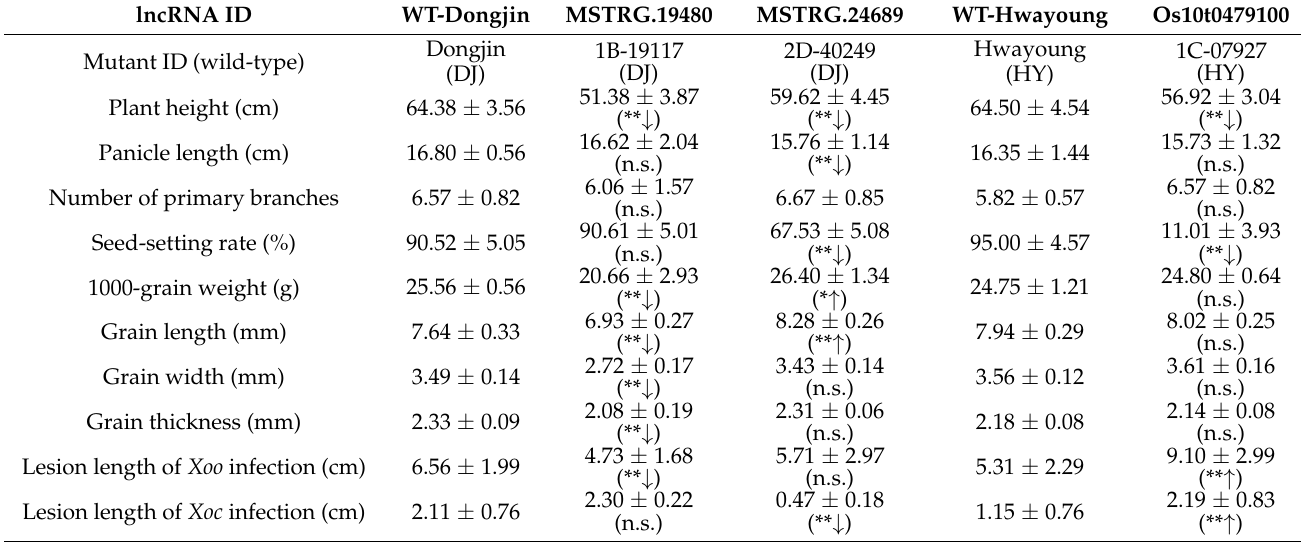
Figure 5. Phenotype analysis of the T-DNA insertion mutants of three conserved lncRNAs in rice domestication. ( a – d ) The diagram of T-DNA insertion site in MSTRG.19480 ( a ) and grain size analysis for this mutant and its wild-type Dongjin, the scale bar for grain length ( b ), grain width ( c ) or grain thickness ( d ) is 2 cm. ( e – g ) The diagram of T-DNA insertion site in MSTRG.24689. ( e ) and phenotype analysis for this mutant and its wild-type Dongjin. The scale bar is 5 cm for panicle ( f ) and 2 cm for grain length ( g ). ( h , i ) The diagram of T-DNA insertion site in Os10t0479100 ( h ) and phenotype analysis for this mutant and its wild-type Hwayoung. The scale bar for panicle ( i ) is 5 cm. Table 2. Agronomic traits of mutants of three conserved lncRNAs during